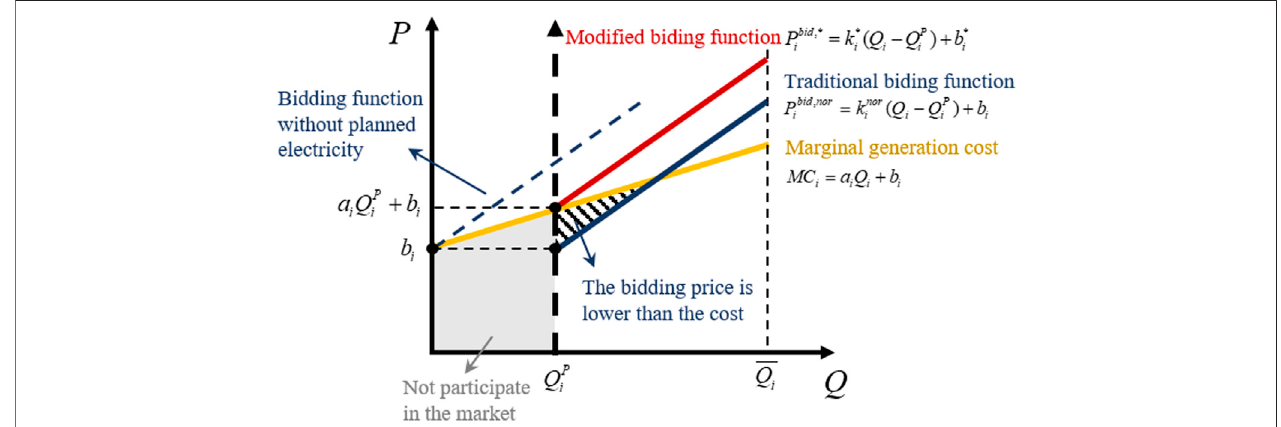
FIGURE 1 | The bidding function of GCs under the PMDM.